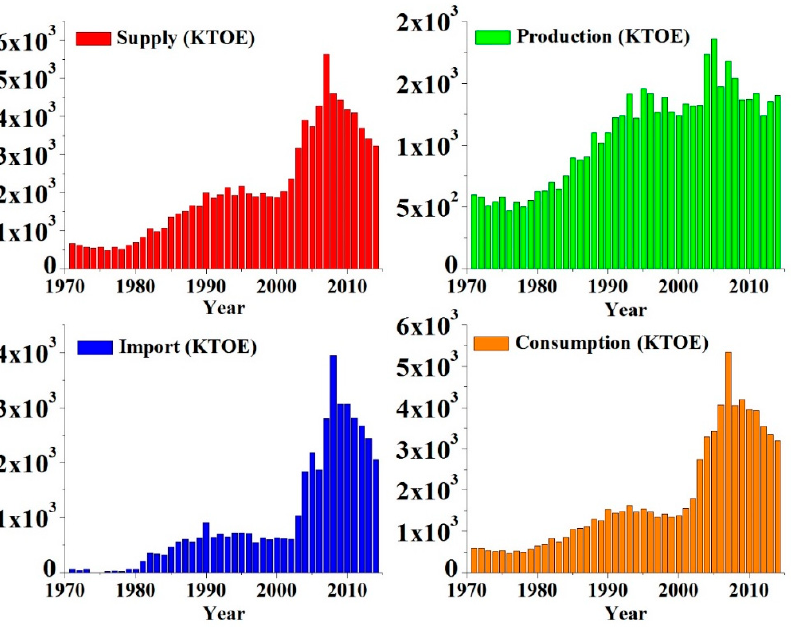
Figure 9. Historical Supply, production, consumption and import of coal (ktoe).